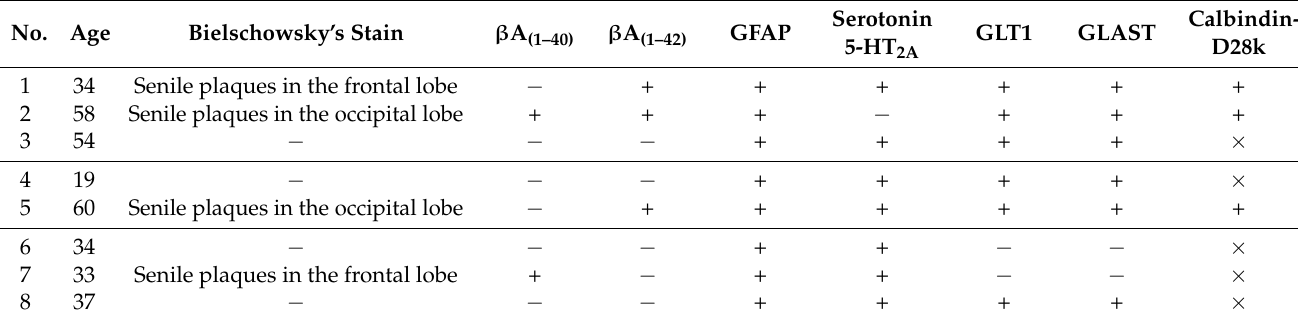
Figure 9. Case no. 2 Cerebellar cortex. Slightly attenuated immunohistochemical reaction with cal ‐ bindin ‐ D ‐ 28k antibody in Purkinje cells (arrow). Slightly thinned neurons in the granular layer (as ‐ terisk). Magnification 200×.